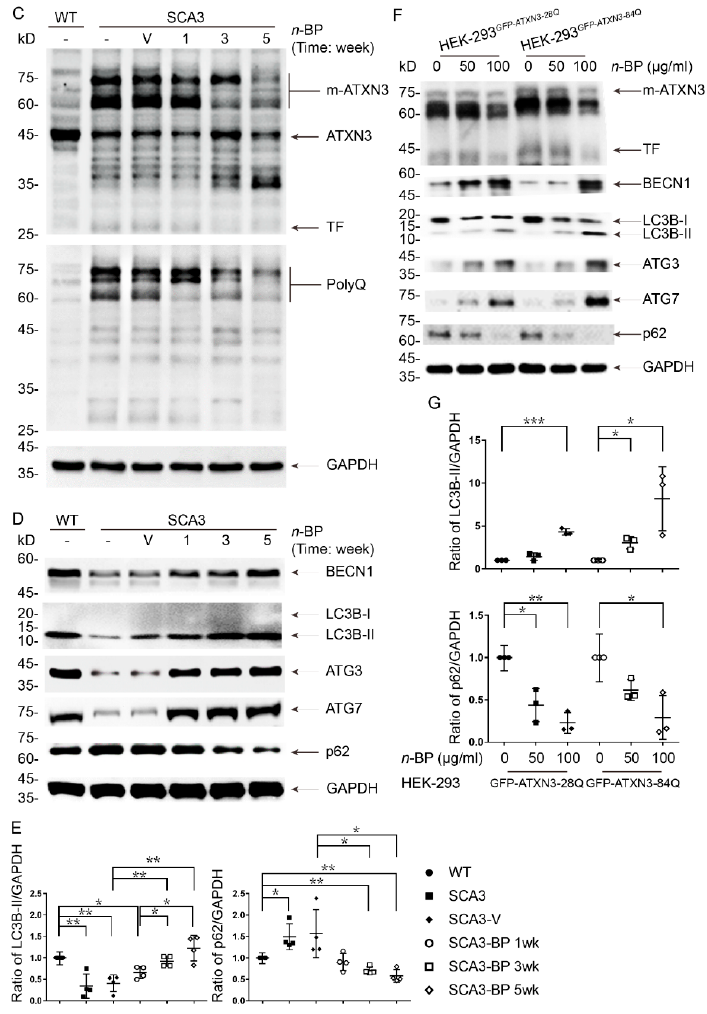
Figure 3. n -BP reduced mutant ATXN3 aggregates and toxic fragments through promoting autophagy in vitro and in vivo. The ATXN3 aggregates ( A ) and the polyQ proteins ( B ) (red, Alexa Fluor 594 conjugated) were located at the Purkinje cells (green, Alexa Fluor 488 labeled) in the cerebellum tissues from 28-week-old mice. Hoechst 33342 was used to label nuclei. Arrows mark the colocalization of ATXN3/polyQ and calbindin in the zoomed images. Bar = 50 μ m. ( C ) Each sampling cerebellum was analyzed to identify the expression of mutated ATXN3 (m-ATXN3) with polyQ expansion (polyQ) and toxic fragments (TFs) by Western blotting assay. n -BP administration could efficiently decrease the accumulation of these abnormal proteins versus vehicle or non-treated SCA3 mice. Arrow indicates the wild-type ATXN3 at 45 kD. ( D , E ) The representative Western blot analysis showing the increased level of BECN1, LC3B-II, ATG3, and ATG7 and a concurrent decreased expression of p62 detected in the murine cerebellum from WT and SCA3-BP groups. Anti-LC3B, p62, and GAPDH antibodies were used on the same blot. The ratios of LC3B-II and p62 to GAPDH were calculated using ImageJ software and normalized to WT. ( F , G ) HEK-293 cells transfected with GFP-ATXN3-84Q or control GFP-ATXN3-28Q were treated with n -BP (50 or 100 μ g/mL) or vehicle (0 μ g/mL). After 6 h treatment, cell samples were subjected to the immunoblotting assay. Findings suggested that n -BP could reduce the accumulated m-ATXN3 and TFs and the expression of p62 in HEK-293 GFP-ATXN3-84Q cell models. Consistently, expression of autophagic players including BECN1, LC3B-II, ATG3, and ATG7 could be induced by n -BP. GAPDH, LC3B-II, and p62 were detected on the same blot. The ratios of LC3B-II and p62 to GAPDH were calculated and respectively normalized to control or HEK-293 GFP-ATXN3-84Q cells. GAPDH was used as an internal control. Data represent mean ± s.d.; * p < 0.05, ** p < 0.01, *** p < 0.001 (Student’s t -test). All experiments were repeated at least three times.